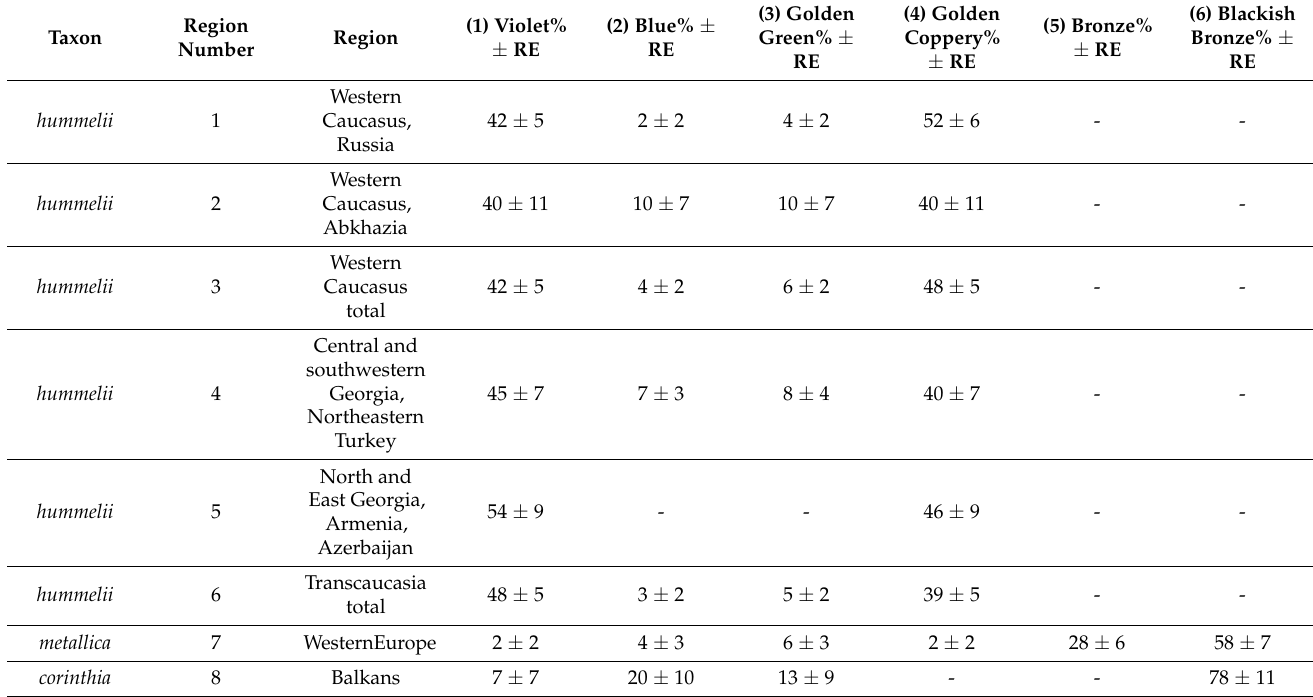
Table 8. Dorsal color. RE—share representativeness